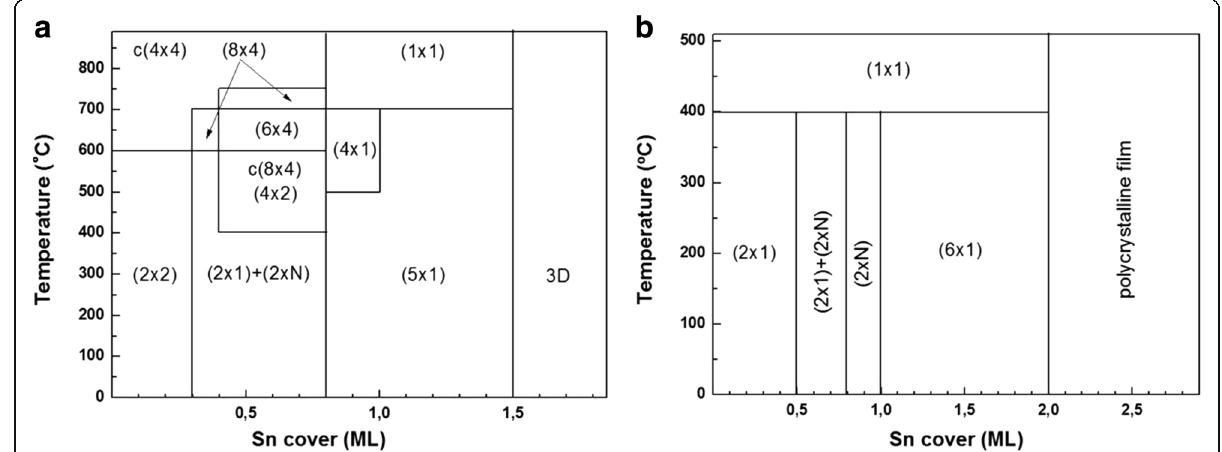
Fig. 3 Phase diagrams of the change of the superstructure during growth: a Sn on Si(100) and b Sn on